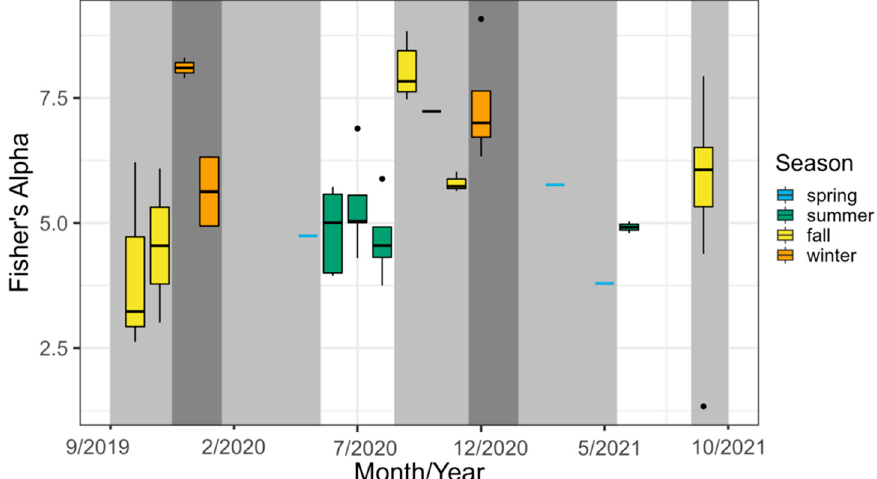
Figure 5. Fisher’s alpha diversity index over time. Background shading and boxplot colors indicate stages in the annual cycle (dark grey shading, over ‐ wintering; light grey shading, migration; green boxplots, summer; yellow box plots, fall; orange boxplots, winter; blue boxplots, spring). Boxplots show the median and interquartile range; whiskers include all observations within 1.5 x IQR (interquartile range), and outliers are represented by points.